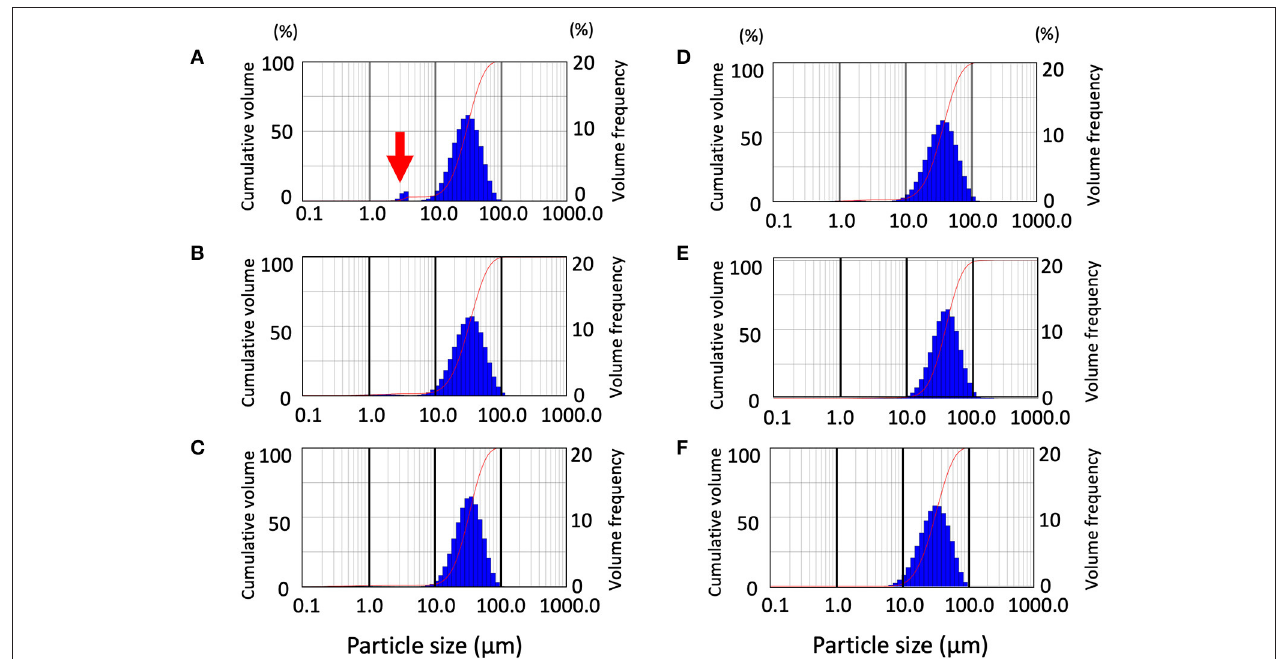
FIGURE 3 | Distribution pattern of droplet size emitted from the dental engine at various speeds and validation of the effect of extraoral suction. Data from the through-cylinder is shown. Droplet size distribution (DSD) histogram graph emitted from the dental engine at the speed of 200,000 rpm (A) , 100,000 rpm (B) , 5,000 rpm (C) . Distribution pattern of droplet size emitted from the dental engine with extraoral suction by low set with 180 degrees, strong set with 180 degrees, and strong set with 90 degrees ( D–F , respectively). The curves in the graphs represent the droplet cumulative volume frequency and the percentage of a particular size of the droplet. Each experiment was performed independently at least four times, and the results of one representative experiment are shown.